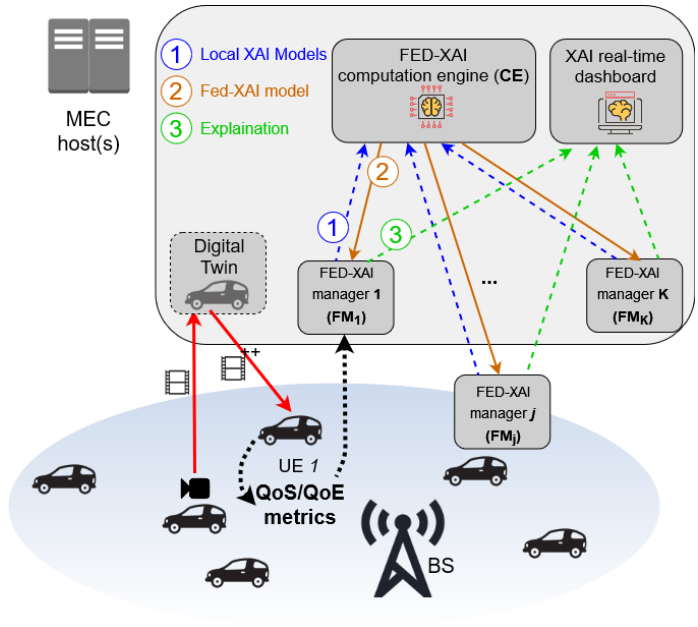
Figure 2. Example of video flow (red arrows) and related QoS/QoE metrics reporting (dashed black arrows) in a MEC-enabled FED-XAI architecture. Interaction among FM, CE and a real time XAI dashboard is also